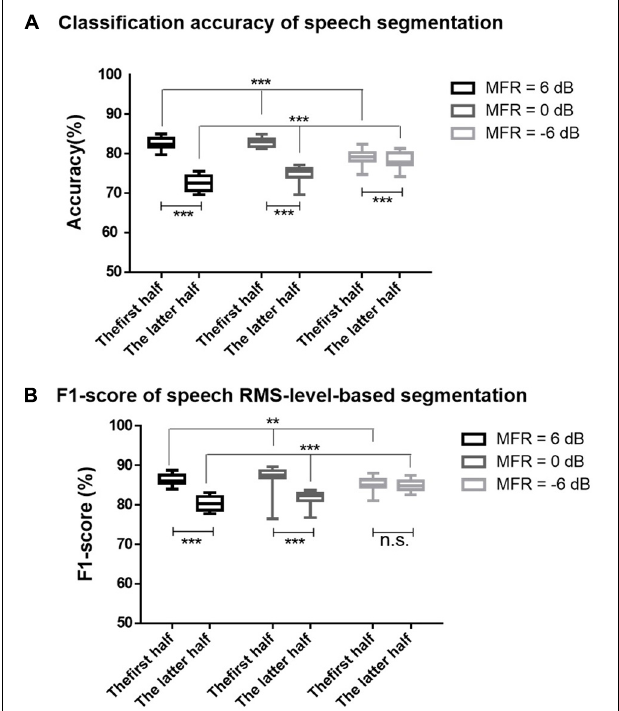
FIGURE 3 | (A) The accuracies for the classification of higher- and lower-RMS-level speech segments using SVM classifier under 6-dB (black signs), 0-dB (dark gray signs), and –6-dB (light gray signs) MFR conditions before and after the switching of the auditory attention at the middle time of the 60-s trails. (B) The F1-scores for the classification of higher- and lower-RMS-level speech segments under 6-dB (black signs), 0-dB (dark gray signs), and –6-dB (light gray signs) MFR conditions in the first half and the latter half. The bars represent the max and min values of each condition, *** indicates P < 0.001, ** indicates P < 0.01, and n.s. indicates P >